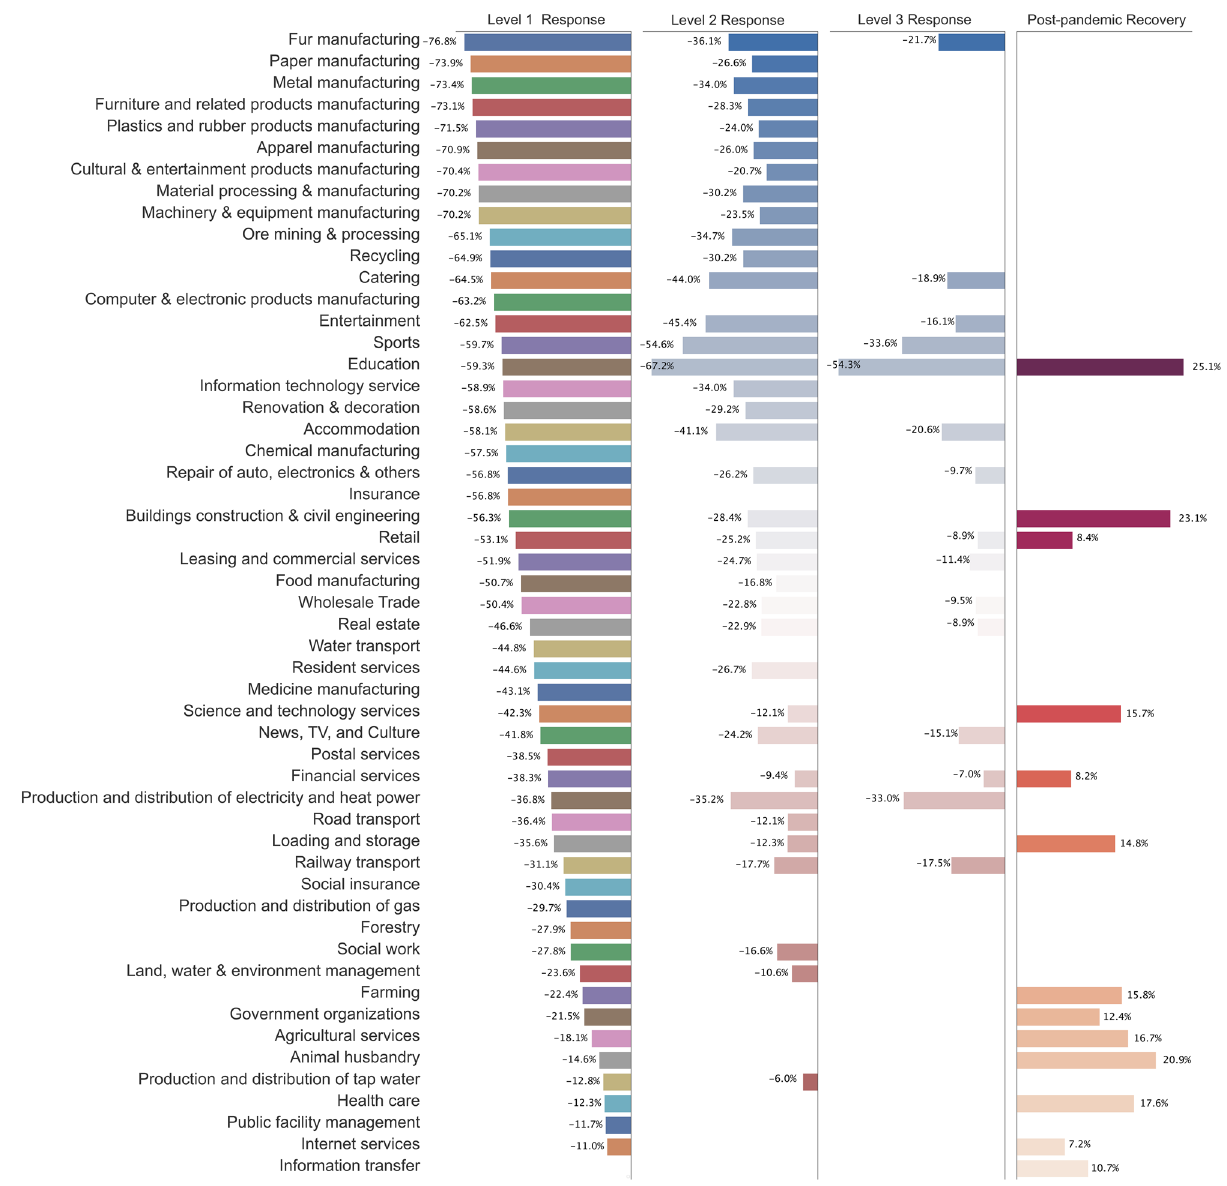
Figure 4. Multi-period causal impacts on electricity consumption of 53